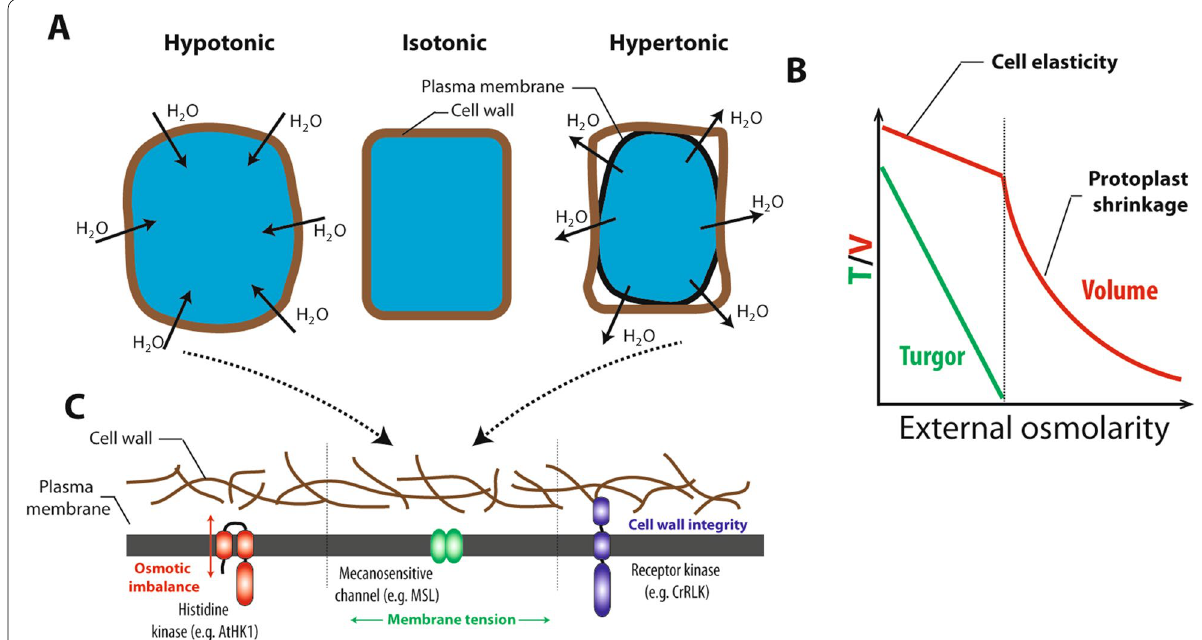
Fig. 1 Nature of the osmotic signal and suspected sensing mechanisms. A Drawing of the relation between osmotic, water fluxes and cellular volume regulation. A reduced (hypotonic) or increased (hypertonic) external osmolarity results in an influx or efflux of water, respectively. Depending on cell wall elasticity, these fluxes lead to changes in cellular volume. B Relative variations of cell turgor and volume in response to an increase of external osmolarity. In the absence of cellular osmoregulation, the turgor tends to decrease linearly with increasing osmolarity. In contrast, the cellular volume is expected to decrease in a two-phase mode, a quasi-linear mode as long as turgor is maintained in the cell, followed by a hyperbolic decay when turgor is absent. C Based on the literature 3 classes of perception mechanism can sense the osmotic signal. Osmotic signal may be perceived at the membrane from either a local osmotic imbalance (e.g. AtHK1) or a change in membrane tension (e.g. MSL) or from a perturbation of cell wall integrity (e.g.